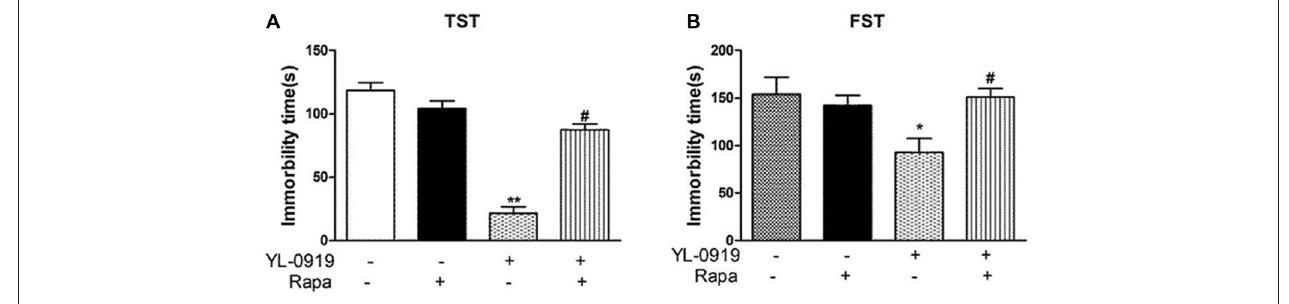
FIGURE 1 | Effects of YL-0919 and rapamycin (Rapa) on depression-like behavior in mice. (A) Tail Suspension Test (TST) and (B) Forced Swimming Test (FST). Rapamycin was administered intracerebroventricularly (i.c.v.) at a final concentration of 0.2 mmol in 2 µ L DMSO, with DMSO as a vehicle control 12 h before treatment with YL-0919 (2.5 mg/kg) or fluoxetine (Flx; 10 mg/kg, both-administered i.g.). The TST and FST were performed 1 h after YL-0919 application. n = 8; ∗ ,# P < 0.05, ∗∗ P < 0.01; ∗ ,# compared to vehicle and YL-0919, respectively; two-way ANOVAs followed Tukey’s post hoc test.